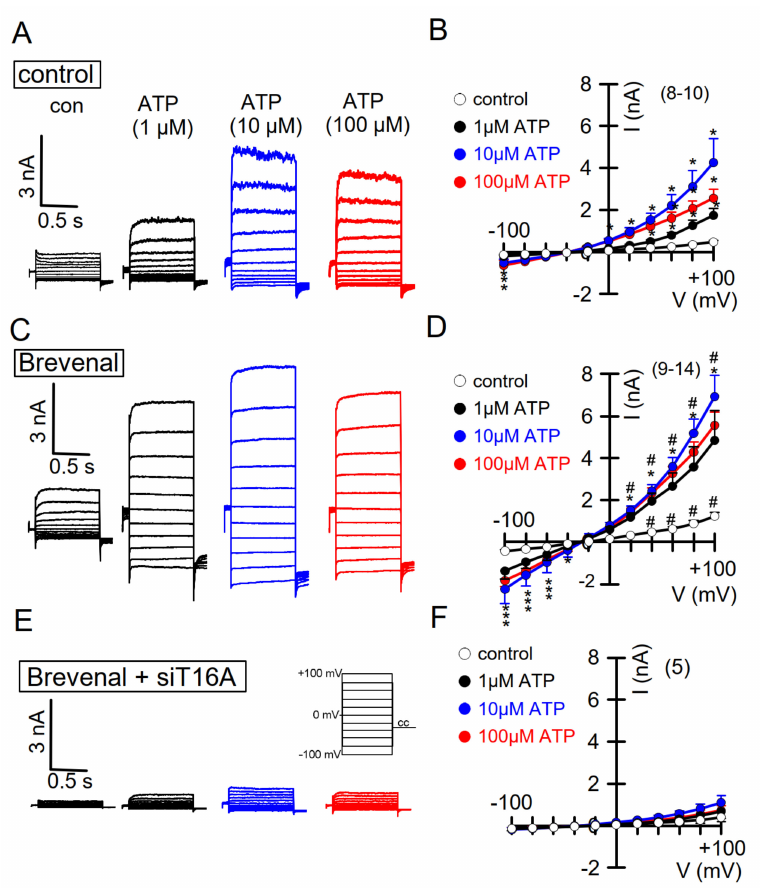
Figure 7. Activation of TMEM16A whole-cell currents is potentiated by brevenal. ( A ) Dose- dependent activation of endogenous TMEM16A whole-cell currents in CFBE airway epithelial cells, by the purinergic agonist ATP. Clamp voltages ± 100 mV in steps of 20 mV. ( B ) Corresponding cur- rent/voltage relationships. ( C , D ) Activation of whole-cell currents obtained from cells pre-incubated with brevenal (500 nM, 15 min) and corresponding current/voltage relationships. ( E ) Activation of whole-cell currents in brevenal-incubated cells, in which expression of TMEM16A has been knocked down by treatment with siRNA-TMEM16A (c.f. Supplementary Figure E2). ( F ) Corresponding cur- rent/voltage relationships. Mean ± SEM (number of cells). * significant activation by ATP ( p < 0.05, ANOVA). The inhibitor of Ca 2+ -activated KCNN4 K + channels, TRAM-34 (100 nM), was present in all patch clamp experiments to avoid potential activation of Ca 2+ -activated K + channels. # significant difference when compared to the absence of brevenal ( p < 0.05, ANOVA). No currents were activated in siRNA-TMEM16A-treated